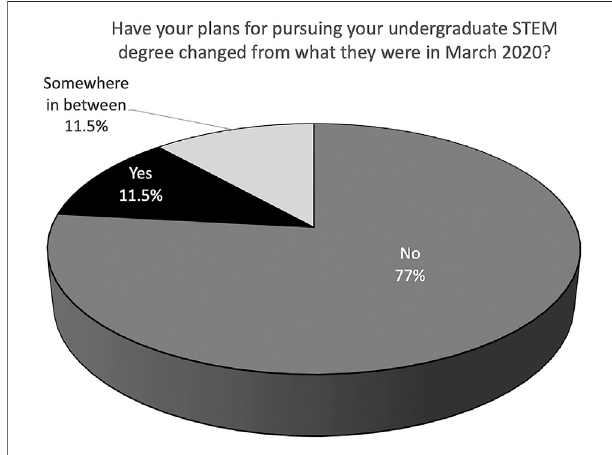
FIGURE 6 | Changes in STEM academic plans: Have your plans for pursuing your undergraduate STEM degree changed from what they were